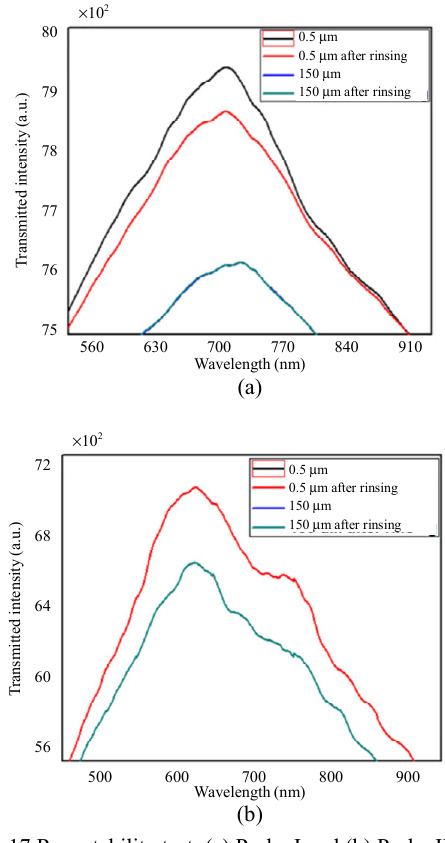
Fig. 17 Repeatability test: (a) Probe I and (b) Probe